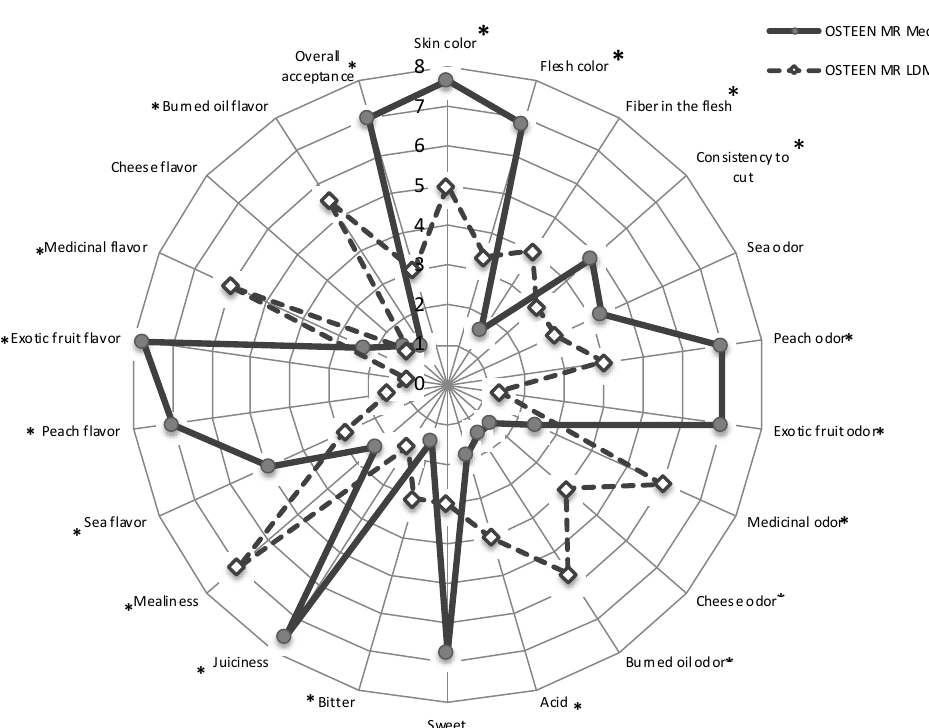
Figure 5. Sensory analysis of mature-green (GR) fresh Mediterranean Italian (MedIT) and imported (LDM) “Osteen” mango fruit. Data are Mean of 15 fruit for each ripening stage. * Indicates significant differences for values (Tukey’s test at p ≤ 0.05).